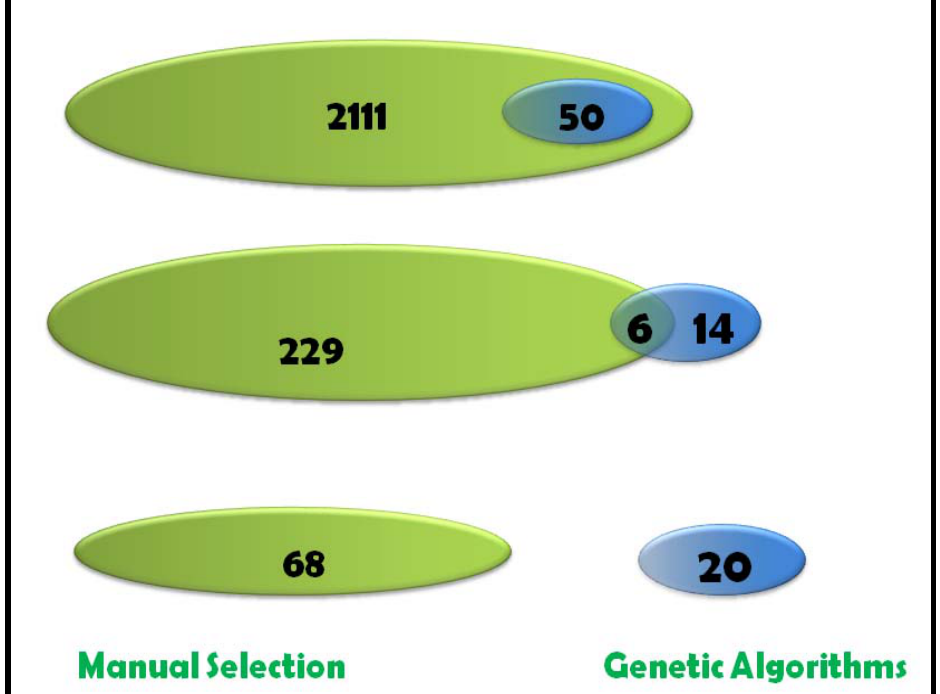
Figure 9. GA and manual feature selection methods generated two unique small subsets of highly potential predictors found during processing HILIC LC-MS data (ccRCC